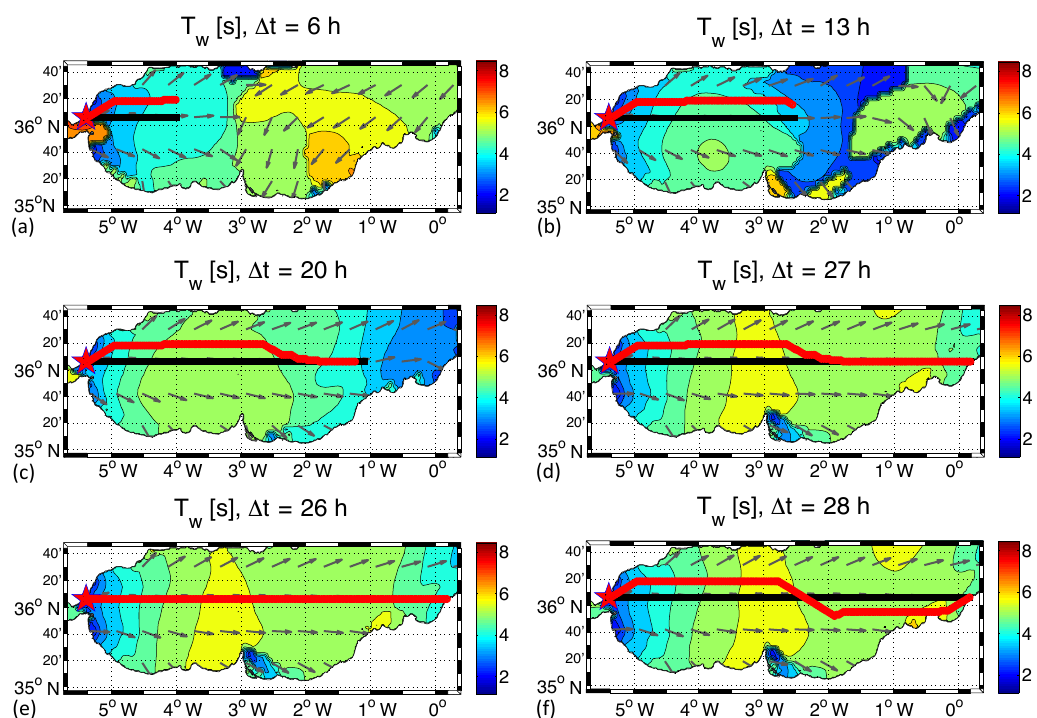
Figure 14. Case study #3. Geodetic (black markers) and optimal (red markers) route from Gibraltar (UK) to Ben Abdelmalek Ramdan (Algeria) for vessel V2 of Table 5 and departure on 5 October 2014 at 22:30UTC. Panels (a–d) refer respectively to timesteps #7, 14, 21, 28 after departure. (e, f) are respectively the last time step of a route with identical parameters but with the safety checks disabled (e) or voluntary throttle reduction disabled (f) . Wave period analysis fields T w are displayed with colour shadings and wave directions are displayed with arrows. Animation of the route is provided at http://dx.doi.org/10.5446/18089.